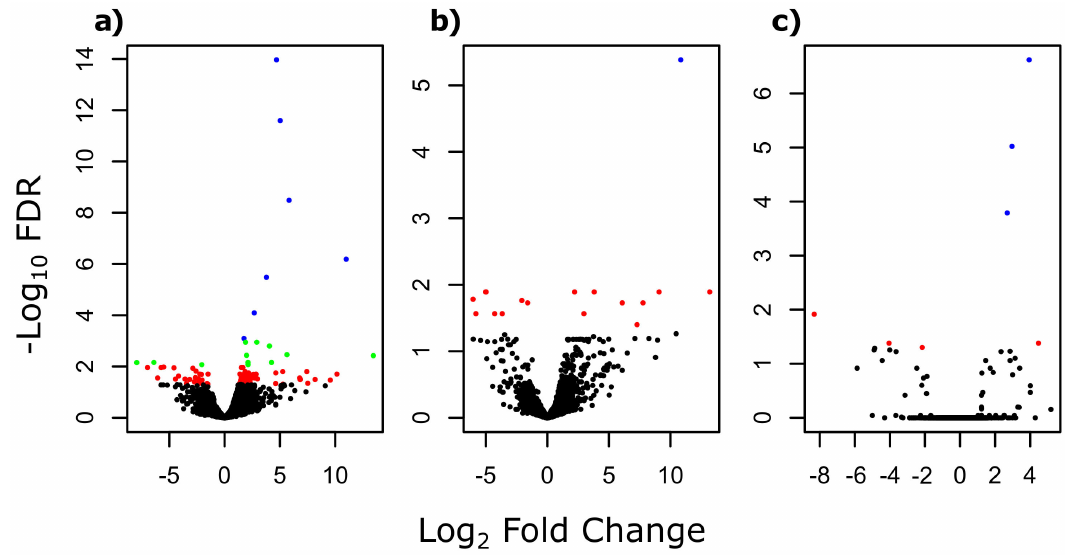
Figure 1. Volcano plot showing the log transformed adjusted p -values (i.e., false discovery rate, FDR) and the log fold changes for the 12,357 protein-coding genes of T. polycolpus transcriptome for: ( a ) the comparison between parasites infecting dace and minnow, respectively, ( b ) the comparison between parasites infecting dace and gudgeon, respectively, and ( c ) the comparison between parasites infecting minnow and gudgeon, respectively. Black dots refer to non-significant differentially expressed genes at a FDR of 5%. Red dots refer to significant differentially expressed genes at a FDR of 5%. Green dots refer to significant differentially expressed genes at a FDR of 1%, and blue dots refer to significant differentially expressed genes at a FDR of